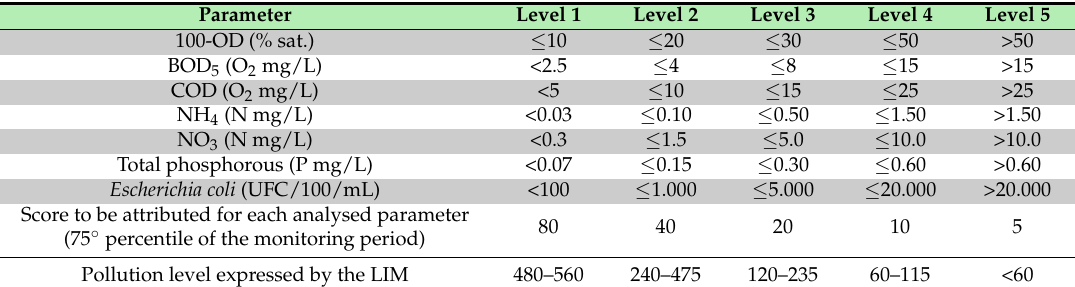
Table A1. Different pollution levels expressed by the macro-descriptor LIM. The reported levels correspond to concentration or percentage and are directly measured after sampling.